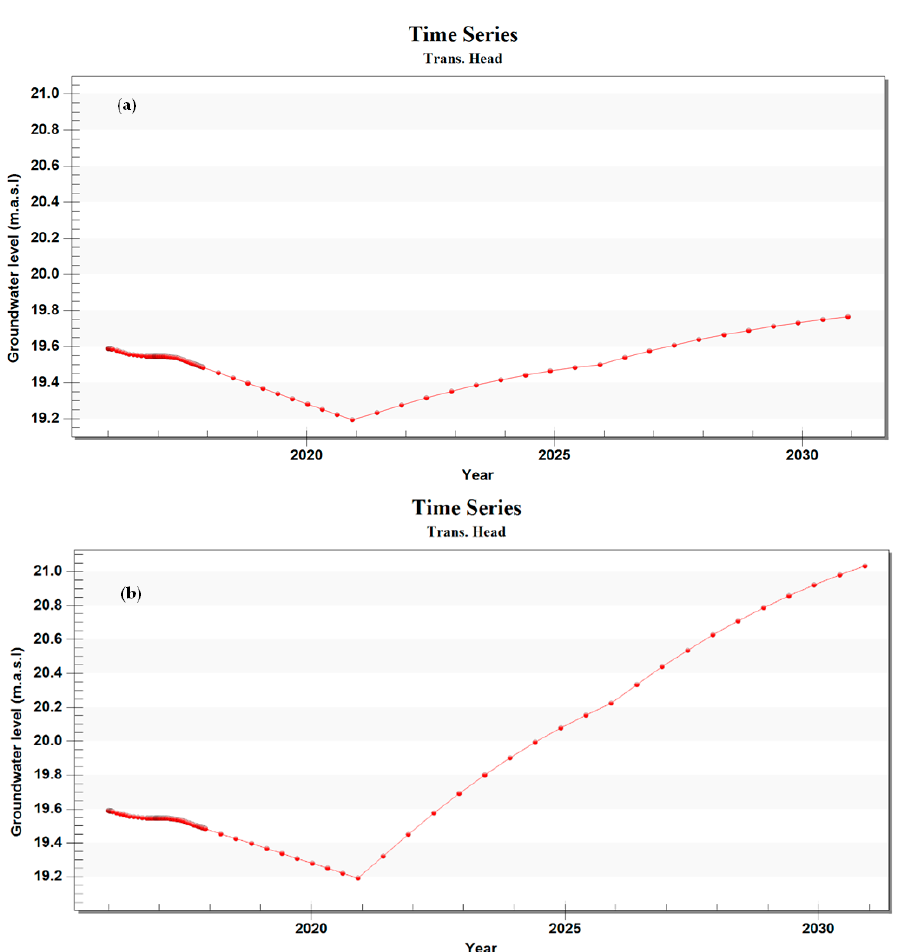
Figure 11. Groundwater level variations in observation well No.3 (Obs.3). ( a ) MOD2 with 5000 m 3 /day and ( b ) MOD3 with 10,000 m 3 /day, artificial recharge rate for period (January 2022 to December 2030).